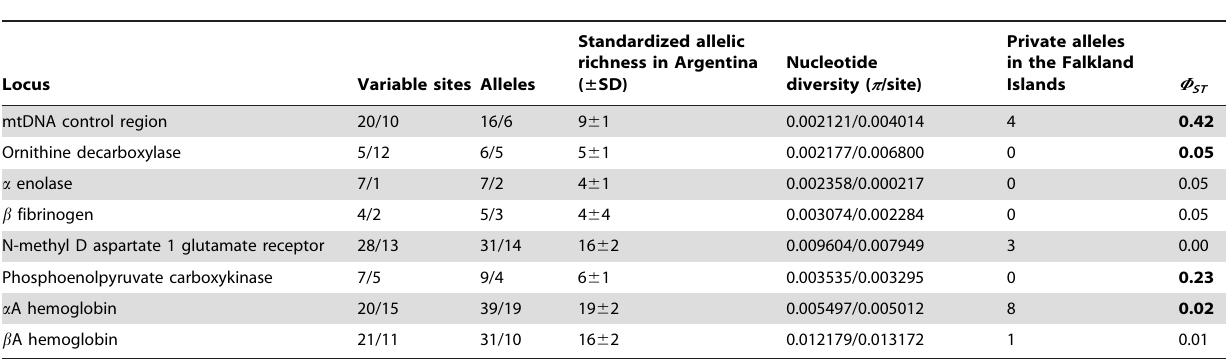
Table 4. Genetic diversity measures (Argentina/Falkland Islands) and W ST between mainland and island populations of speckled teal.